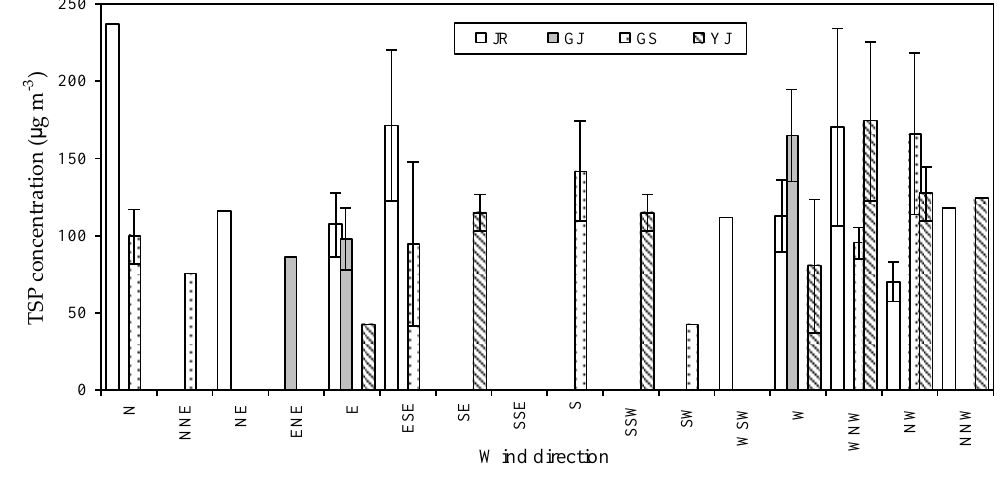
FIGURE 4. Comparison of the TSP concentration levels in relation to wind sectors (1 SD value used for error